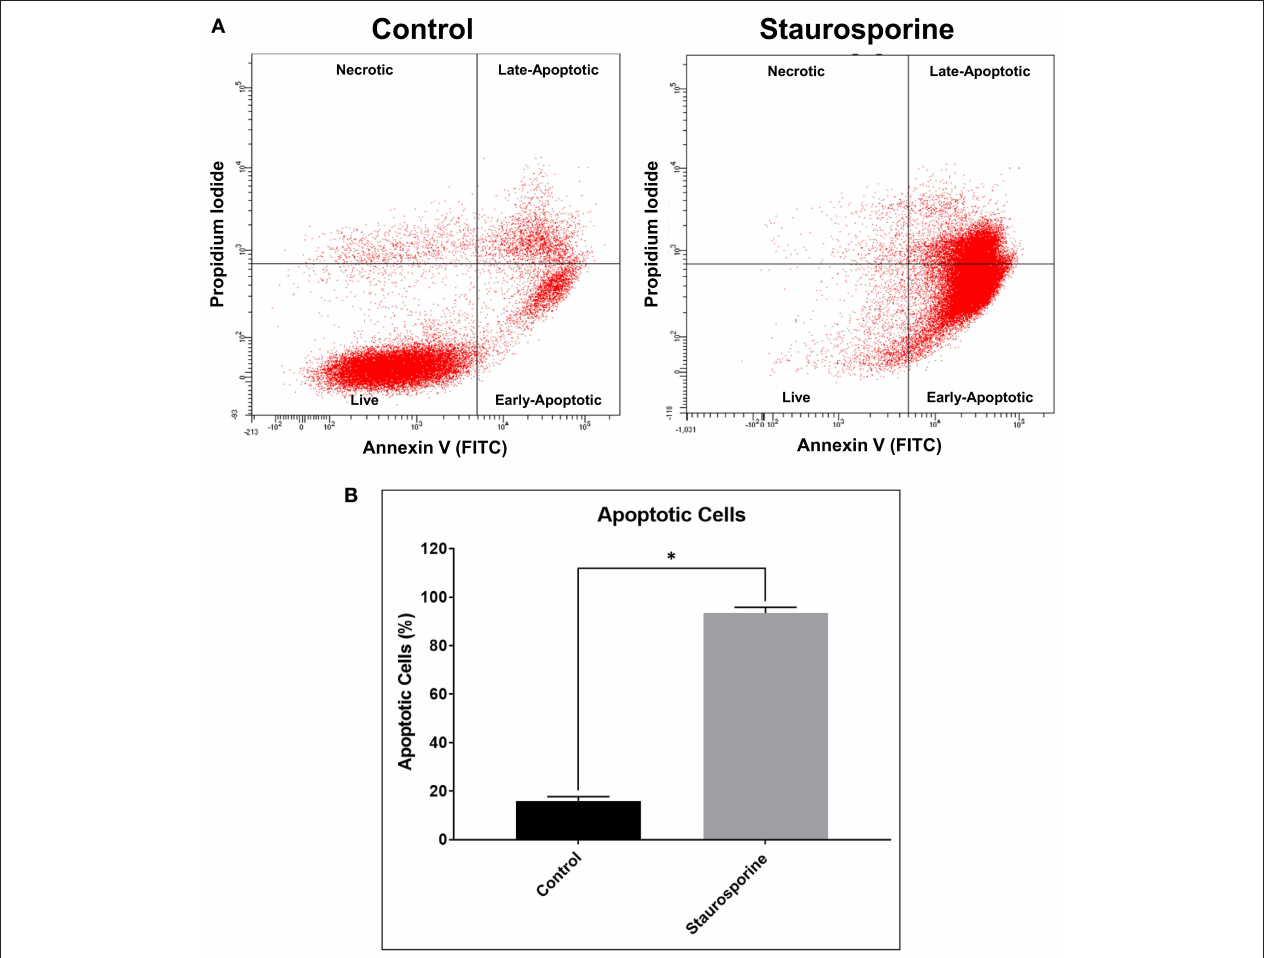
FIGURE 1 | (A) Representative flow cytometry images of cells stained with Annexin V-FITC and propidium iodide after control or Staurosporine (0.5 µ M) treatment for 24h. (B) Plot of apoptotic cells (%). The error bars represent standard deviation ( n = 6); data were analyzed using Wilcoxon test, P = 0.031. * p < 0.05.